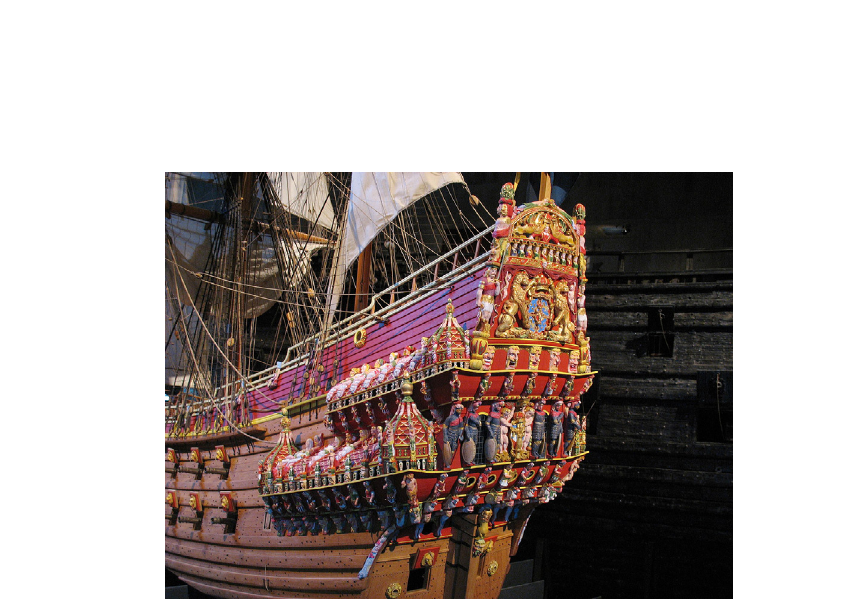
Fig. 16. – 1:10 scale model of the ship on display at the Vasa Museum [36].